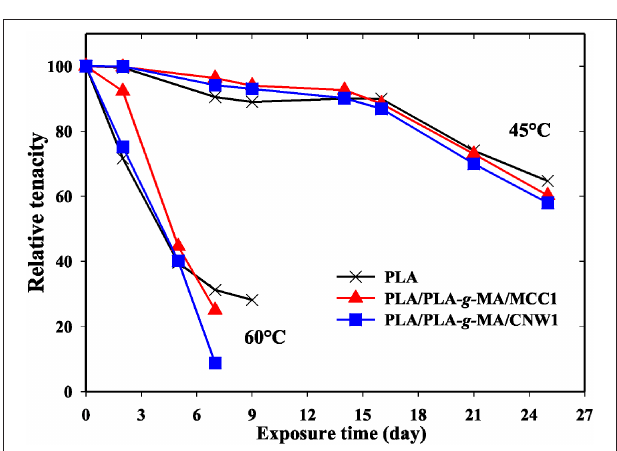
FIGURE 8 | Relative tenacity as a function of exposure time for PLA, PLA/PLA -g- MA/MCC1, and PLA/PLA -g- MA/CNW1 fibers recorded at 45 and 60 ◦ C in hygrothermal